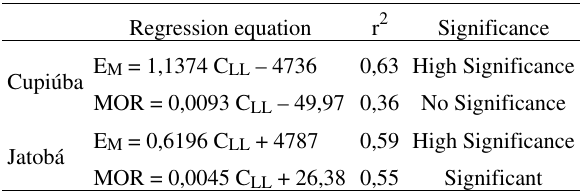
Table 2. Regressions of the modulus of elasticity in bending and of the modulus of rupture as a function of C LL